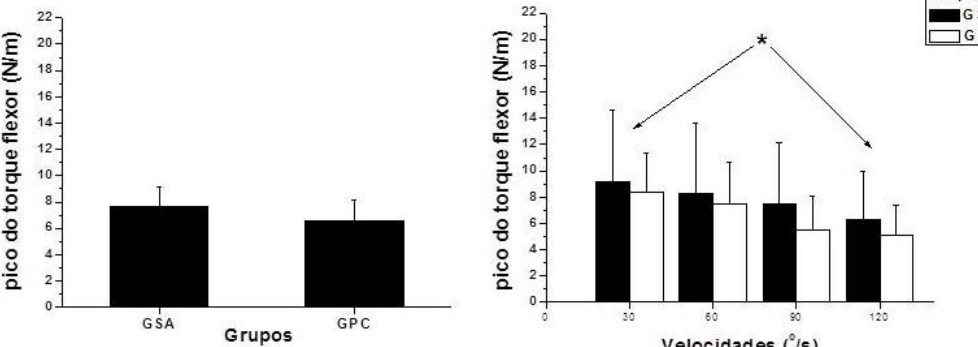
Figura 2. Média e desvio padrão do pico de torque flexor de cotovelo nos grupos GSA e GPC e média e desvio padrão do pico de torque das velocidades 30, 60, 90 e 120°/s. * diferença estatisticamente significante entre 30 e